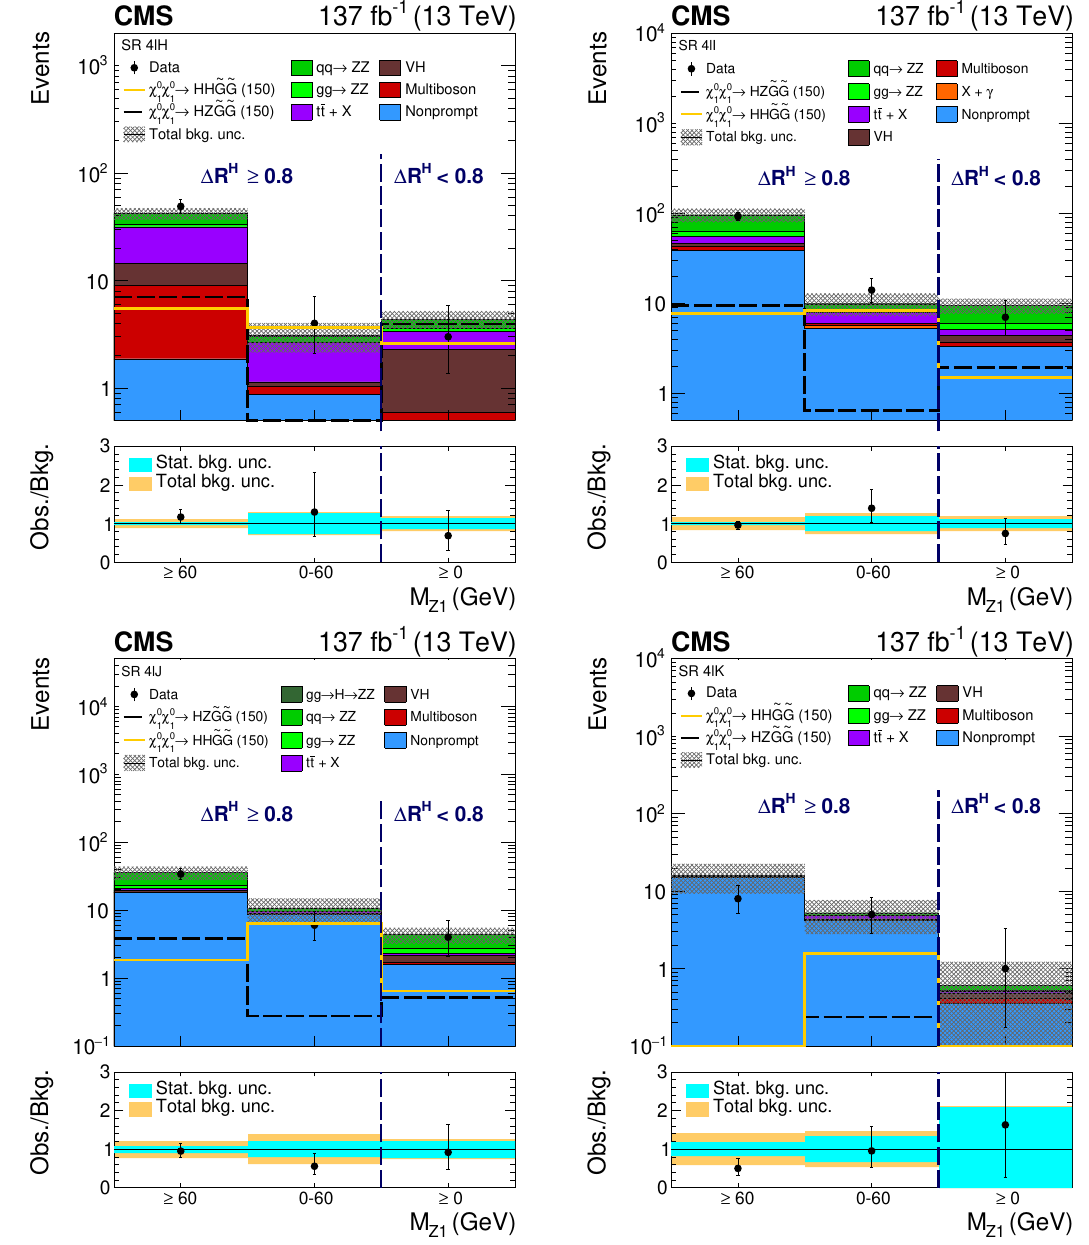
Figure 14 . Observed and expected yields across the search regions in events with four light leptons not forming two OSSF pairs (4 ‘ H, upper left), events with three light leptons and a t (4 ‘ I, upper right), forming two OSSF pairs (4 ‘ J, lower left), and forming one or less OSSF pairs (4 ‘ K, lower right). Several signal models are shown superimposed. They correspond to Higgsino pair production with decays to HZ (dashed black line, Higgsino mass of 150 GeV), and HH (dark yellow line, Higgsino mass of 150